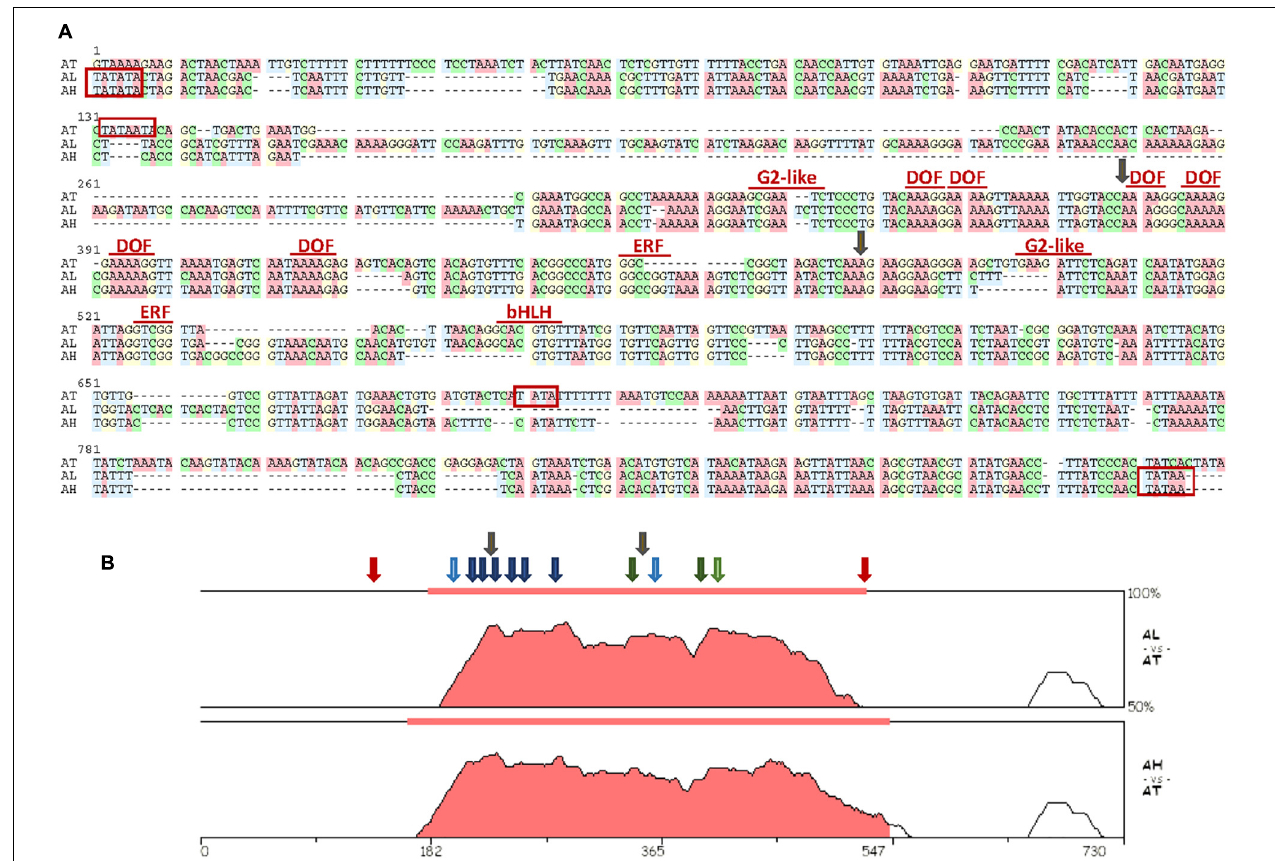
FIGURE 1 | Sequence characteristics of the region spanning the interval between putative TATA sequences in the bifunctional promoter. (A) Alignment of the nucleotide sequences of the selected interval. Names of transcription factor families mark their putative binding sites. TATA predicted sites are boxed in red. Insertion points for the T-DNA lines used are marked by gray arrows. Transcription factors sites were obtained using the binding site prediction tool in the PlantRegMap and the PlantTFDB 4.0 database. Alignment was prepared using the MUSCLE program in the SeaView4 platform. (B) The VISTA plots of pair-wise comparisons of putative bifunctional promoter sequences of A. lyrata and A. halleri species to A. thaliana as generated by the zPicture tool. Filled portions of the graphs indicate conservation of more than 50% with a width of at least 100 bp. Approximate locations of conserved binding sites for transcription factors are marked by arrows (dark blue, DOF; light blue, G2-like; dark green, ERF; light green, bHLH). TATA predicted sites for A. thaliana are marked by red arrows. Insertion points for the T-DNA lines used are marked by gray arrows.